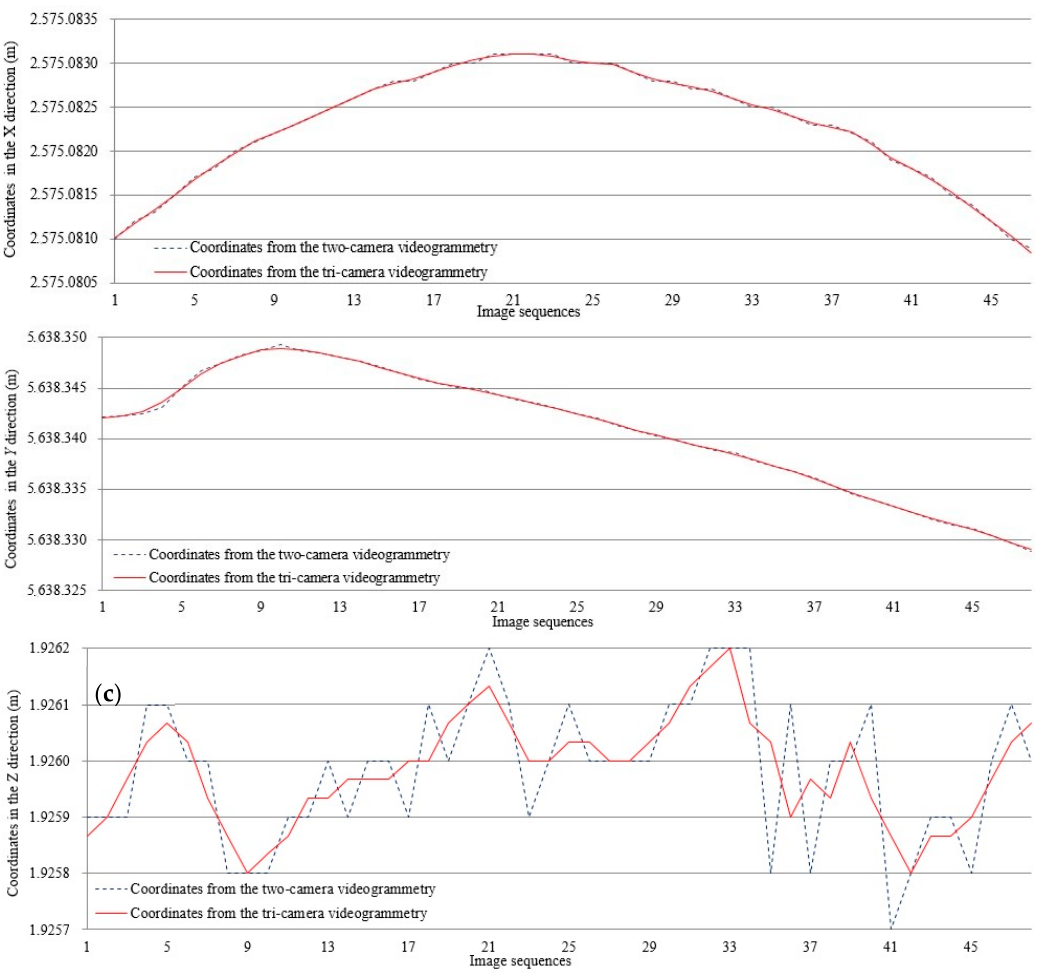
Figure 9. The curves of the coordinate comparison between the tri-camera videogrammetry and two-camera videogrammetry for 50 epochs in the three directions. ( a ) The curves of coordinates of the tri-camera videogrammetry and two-camera videogrammetry for 50 epochs in the X directions, ( b ) the curves of coordinates of the tri-camera videogrammetry and two-camera videogrammetry for 50 epochs in the Y directions, and ( c ) the curves of coordinates of the tri-camera videogrammetry and two-camera videogrammetry for 50 epochs in the Z directions.